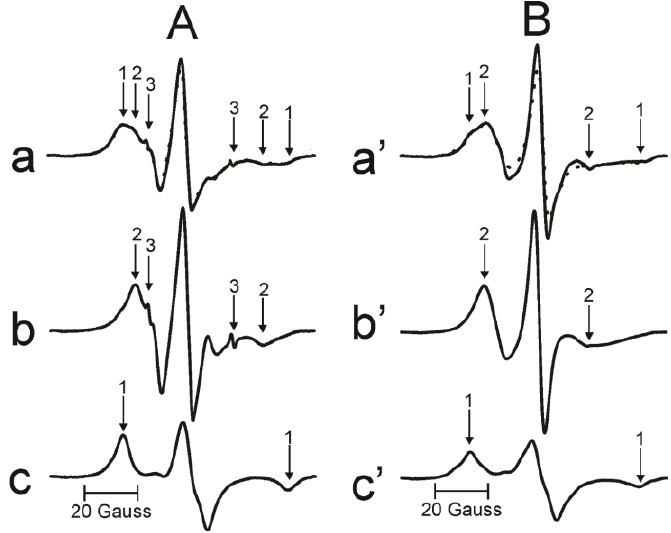
Figure 3. ( A ) The procedure for evaluating the relative amounts of PLs in domains in the lipid bilayer portion of intact membranes is illustrated based on the representative EPR spectrum of 12-SASL in nuclear membranes from the transparent left eye lens of a 46-year-old human donor obtained at 37 ◦ C (( a )-solid line). Arrows 1–3 represent spectra from strongly immobilized, weakly immobilized, and water components, respectively. The EPR spectrum of nuclear LLM obtained with 12-SASL at 37 ◦ C ( b ). The EPR spectrum of the nuclear LLM obtained with 12-SASL at − 18 ◦ C ( c ) (i.e., this spectrum has the same maximum splitting as the strongly immobilized component in spectrum (a-component 1)). The dotted spectrum (( a )-dotted) was obtained by adding 55% of spectrum ( b ) and 45% of spectrum ( c ). (B) The procedure for evaluating the relative amount of Chol in domains in the lipid bilayer portion of intact membrane is illustrated based on the representative EPR spectrum of ASL in nuclear membranes from the cataractous left eye lens of a 65-year-old human donor obtained at 37 ◦ C (( a’ )-solid line). Arrows 1 and 2 represent spectra from strongly immobilized and weakly immobilized components, respectively. The EPR spectrum of nuclear LLM obtained with ASL at 34 ◦ C ( b’ ). The EPR spectrum of nuclear LLM with ASL obtained at − 58 ◦ C ( c’ ) (i.e., this spectrum has the same maximum splitting as the strongly immobilized component in spectrum ( a’ -component 1)). The dotted spectrum ( a’ -dotted line) was obtained by adding 50% of spectrum ( b’ ) and 50% of spectrum ( c’